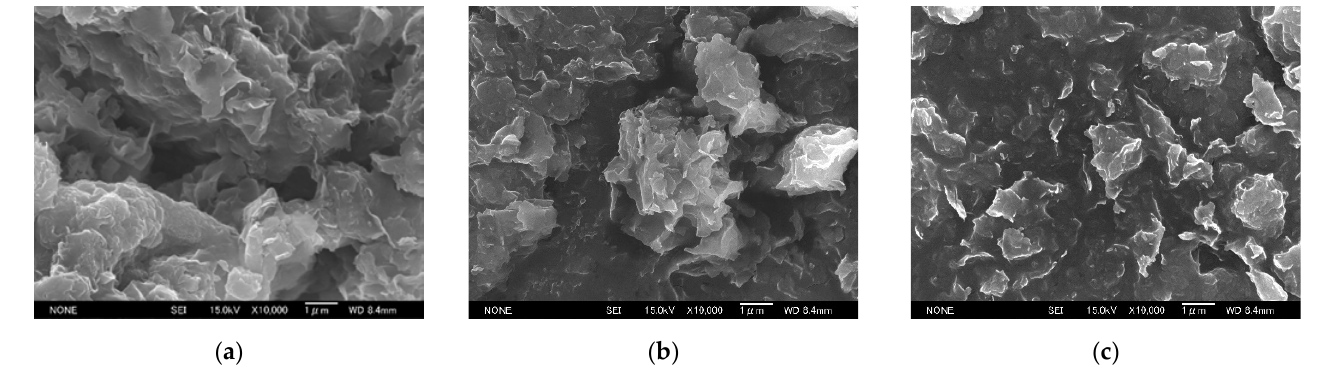
Figure 3. Typical SEM images of ( a ) DA0 (original acid clay), ( b ) DA1 (surface-modified), and ( c ) DA5 (intercalated) samples.